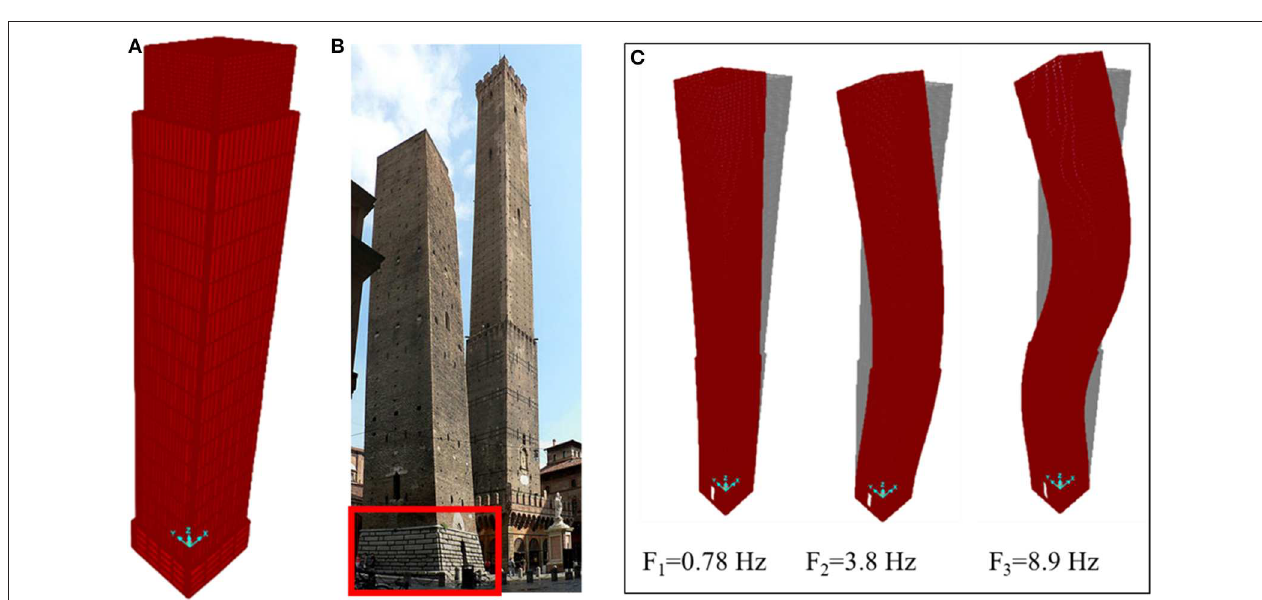
FIGURE 7 | (A) Solid FE model of the Garisenda Tower, (B) external selenitic stones added in the 1889, and (C) first three natural mode shapes of the Garisenda Tower as obtained from the 2D FE model analyses.